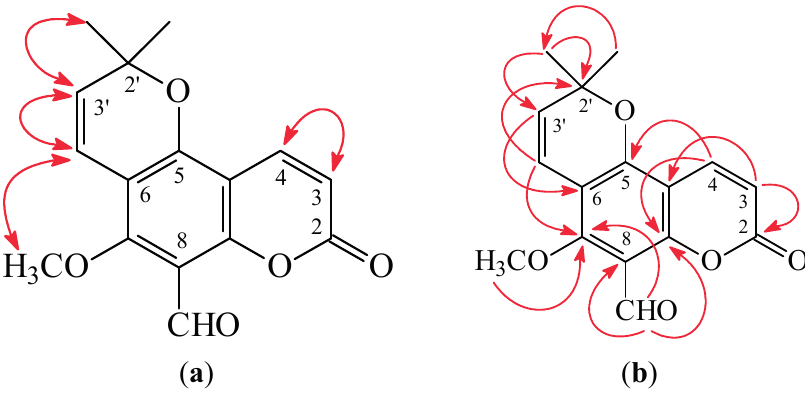
Figure 3. Key nuclear Overhauser effect spectrometry (NOESY) ( a ) and heteronuclear multiple-bond correlation (HMBC) ( b ) correlations of 1